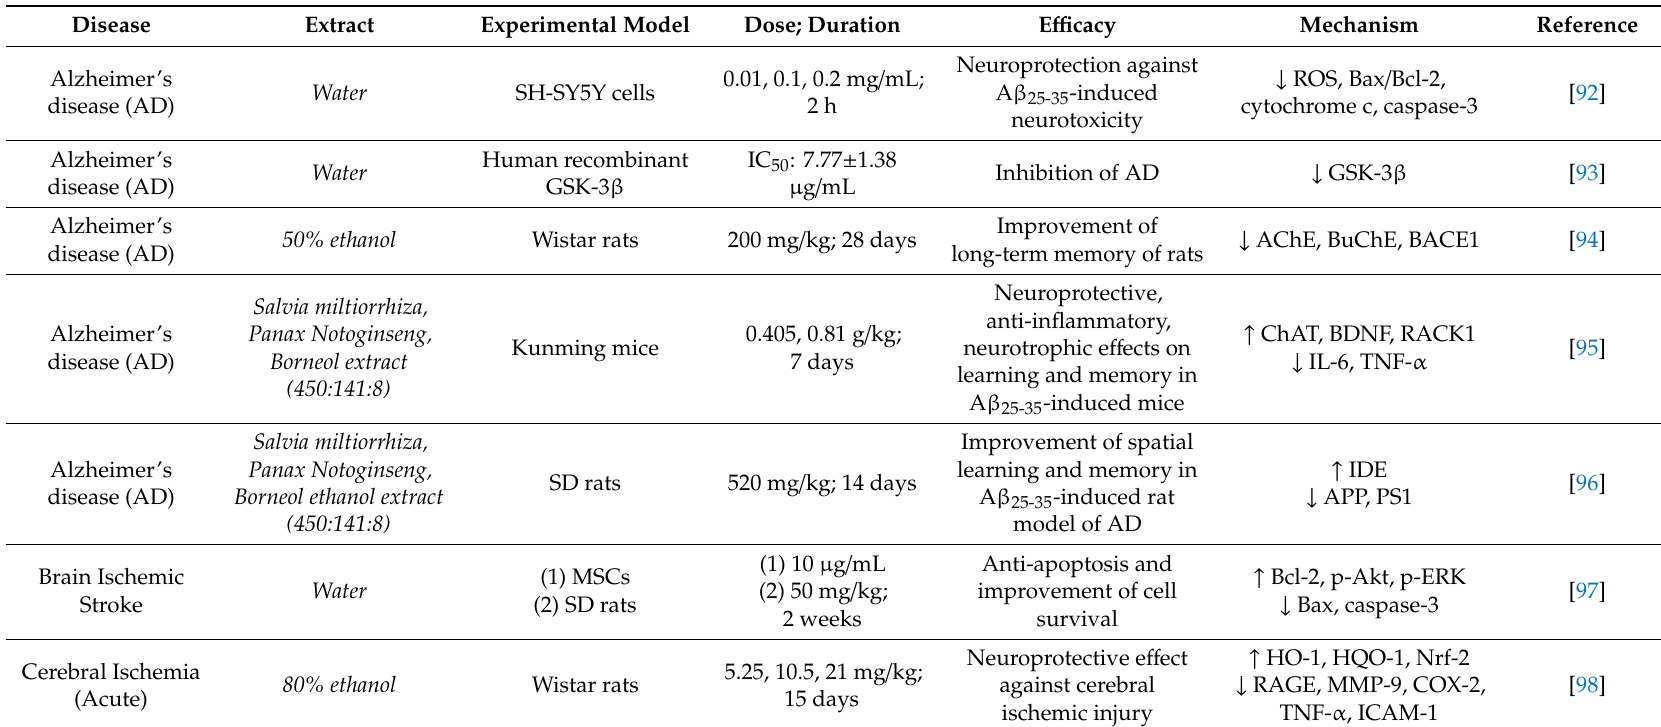
Table 4. Nervous system diseases and S. miltiorrhiza